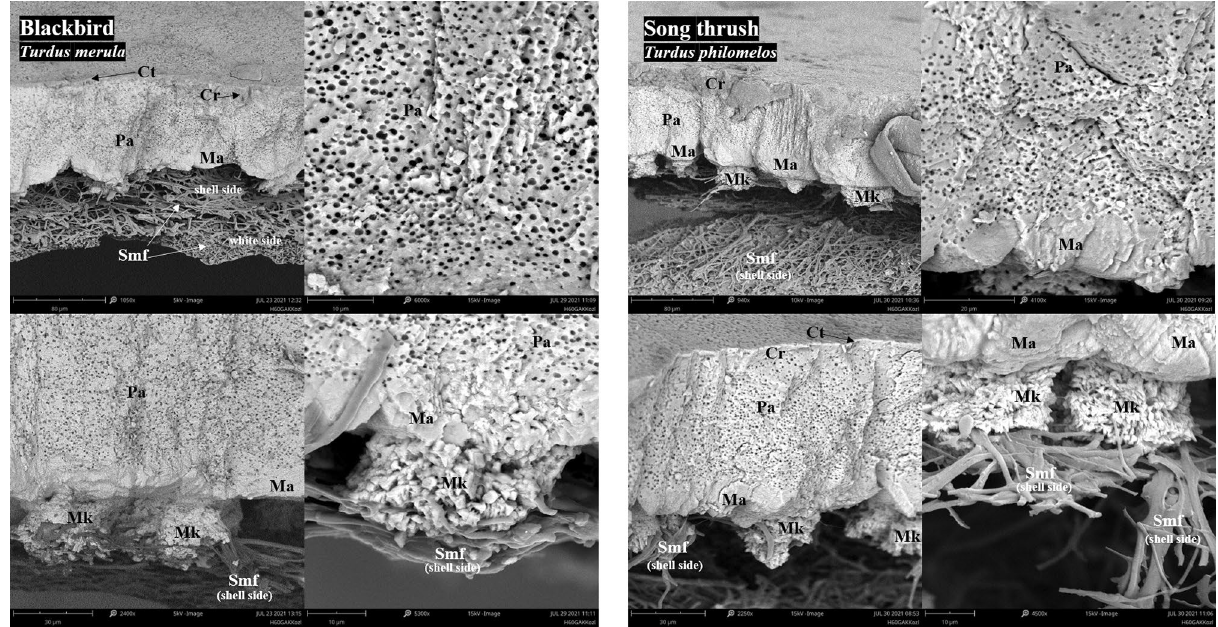
Figure 1. SEM micrograph showing the cross section of the eggshell of blackbird ( Turdus merula ) and song thrush ( Turdus philomelos ). Cuticle (Ct), crystalline layer (Cr), palisade layer (Pa), mammillary layer (Ma), mammillary knobs (Mk), and shell-side or white-side membrane fibers (smf) are evident.